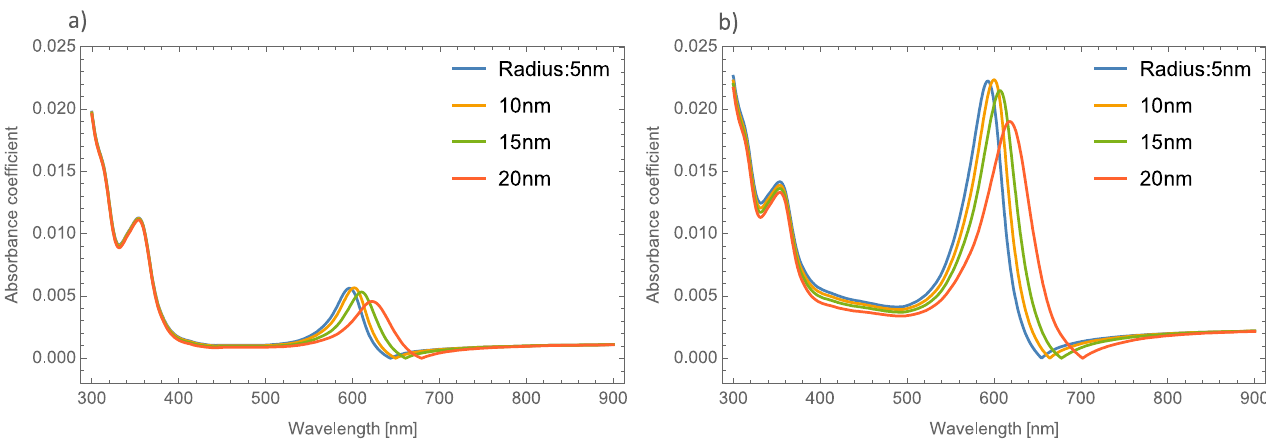
Figure 5. Absorbance coefficient of the MoO 3 thin film doped with Au-NPs with a thickness of 120 nm, ( a ) volume filling fraction of 1% and ( b ) volume filling fraction of 5%. The different NPs radii are indicated.